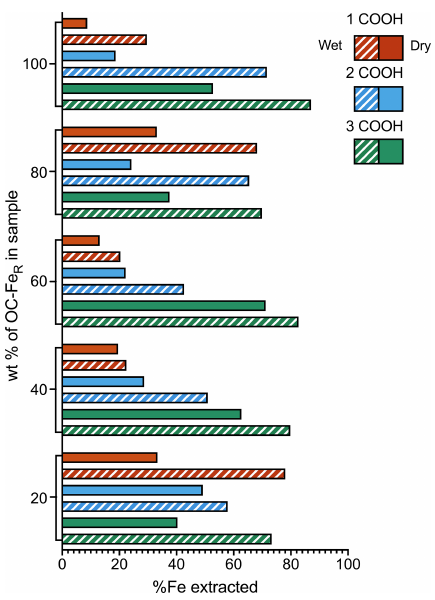
Figure 2. Fe recovery from freeze-dried vs. slurry coprecipitates. Solid bars show dried samples while patterns show the wet (slurry) samples. 1, 2 and 3 COOH refer to the number of carboxyl groups present in the coprecipitated organic acids. Compound maximal in- strument error is minimal and can be found in the data asset.